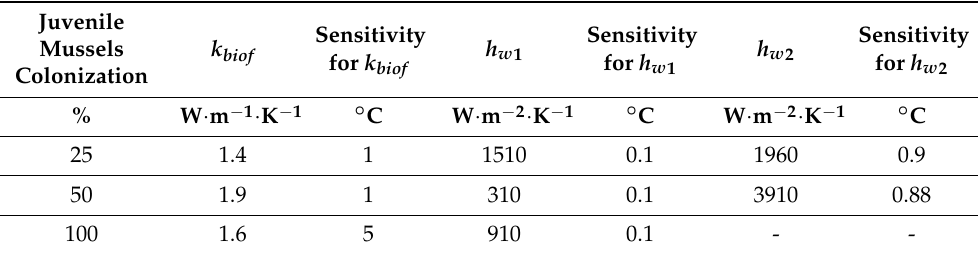
Table 7. Effective thermal conductivity of juvenile mussels and heat transfer coefficient of water around the mussels for different percentage of